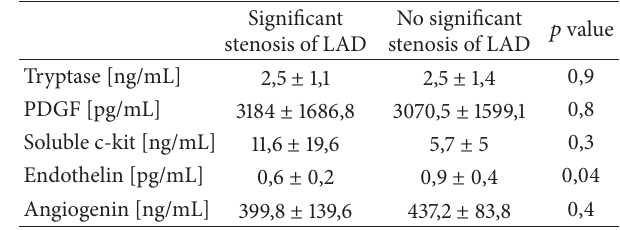
Table 7: The differences in tryptase, PDGF, soluble c-kit, ET-1, and angiogenin levels between STEMI patients with or without family history of CAD. The analysis was made using 𝑡 -test.